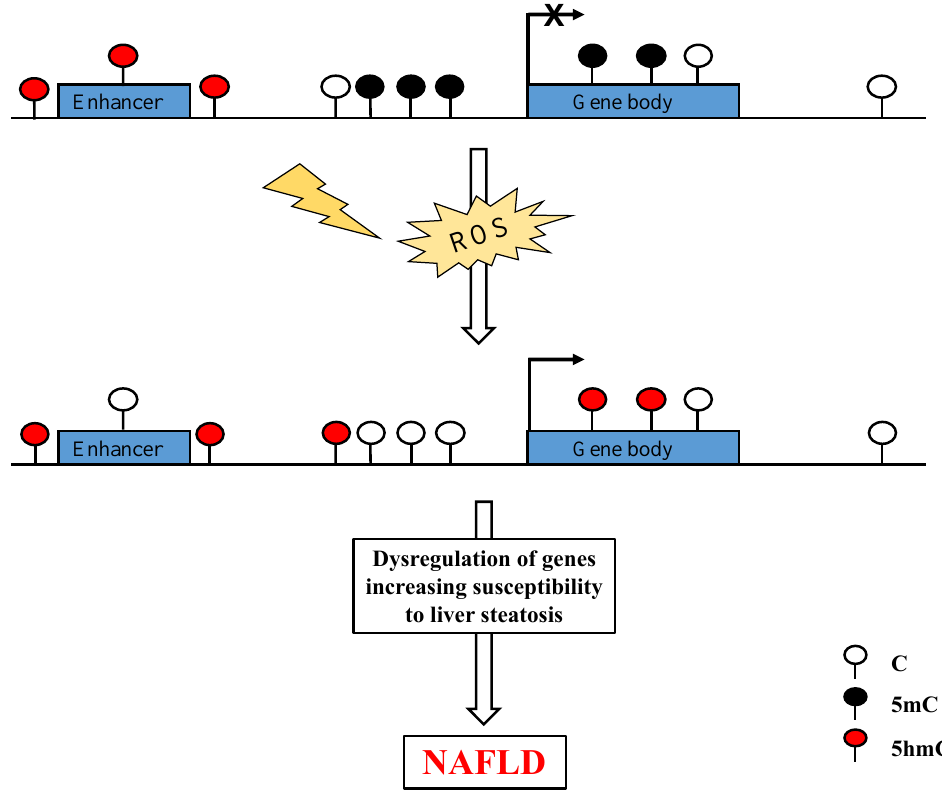
Figure 3. Modulation of 5hmC by oxidative stress. Enrichment of 5hmC is found within promoters, gene bodies, and distal cis -regulatory elements (i.e., enhancers) and is likely to participate in the regulation of tissue-specific expressed genes. Reactive oxygen species (ROS) produced by environmental toxicants and contaminants and/or as by-products of metabolism are known to accumulate within the hepatocytes of NAFLD patients. ROS and oxidative stress can alter the hydroxymethylome, thus affecting the epigenetic reprogramming and transcriptional regulation of key genes involved in lipid metabolism and/or oxidative stress response.